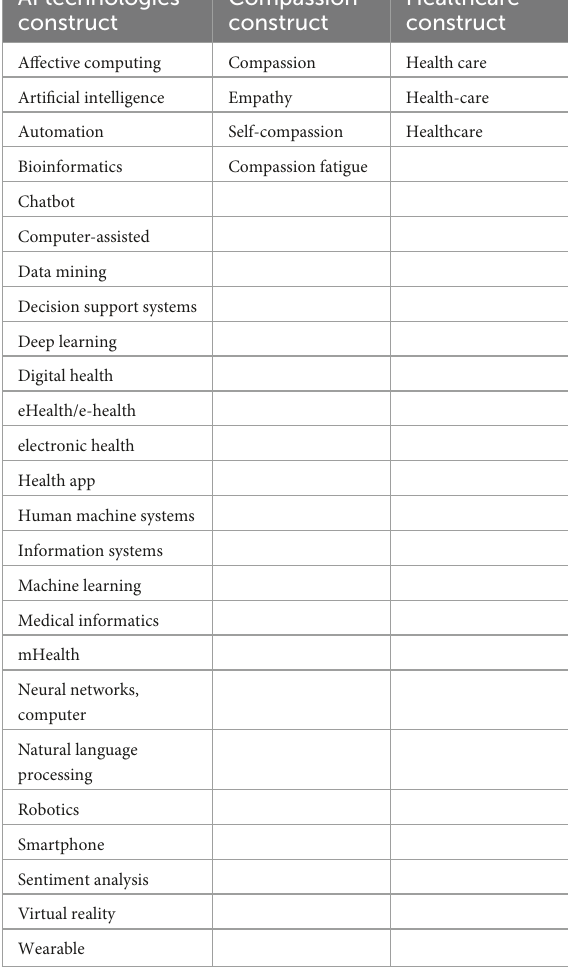
Healthcare construct